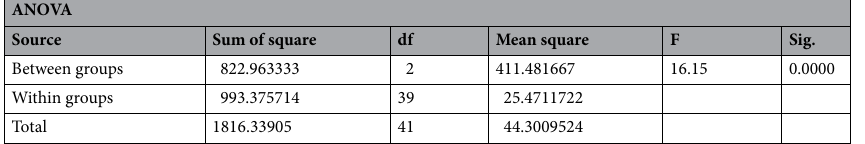
Table 4. Analysis of variance of noise levels for morning, midday and afternoon. Df degree of freedom, Sig. level of Significance.